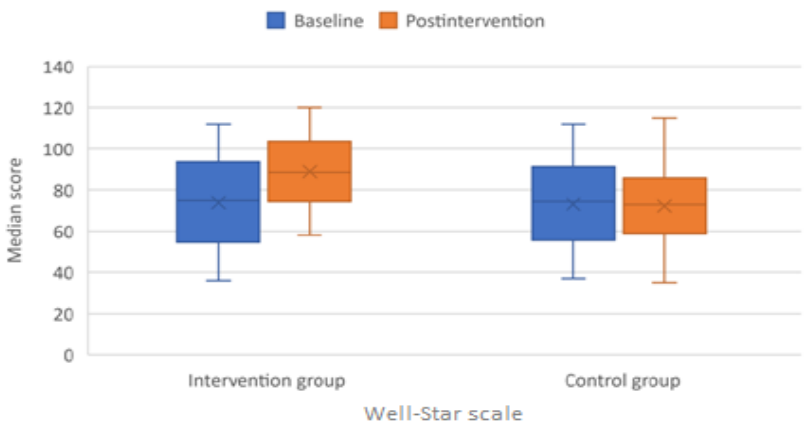
Figure 3. Boxplot graph depicting median scores of Well-Star scale (WSS) at baseline and after in- tervention.